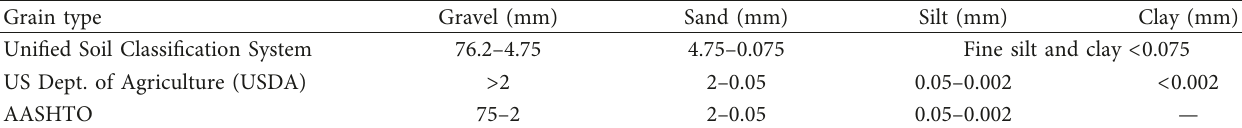
Table 1: Soil separated grain size and limits according to UCS, USDA, and AASHTO specifications .